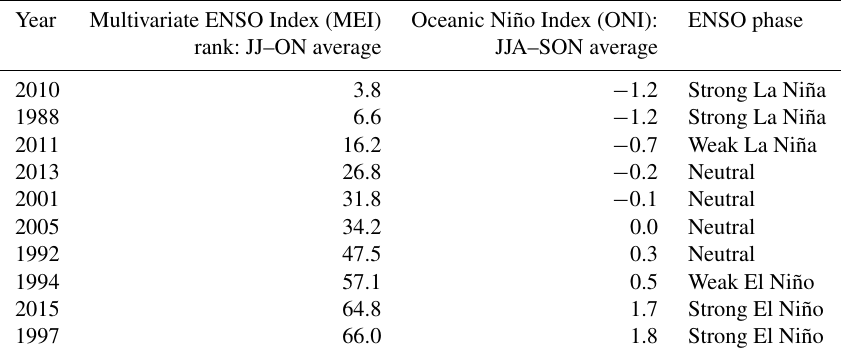
Table 1. Average Multivariate ENSO Index (MEI), Oceanic Niño Index (ONI), and corresponding ENSO phase during the TC season (June–November) for the chosen simulation years.